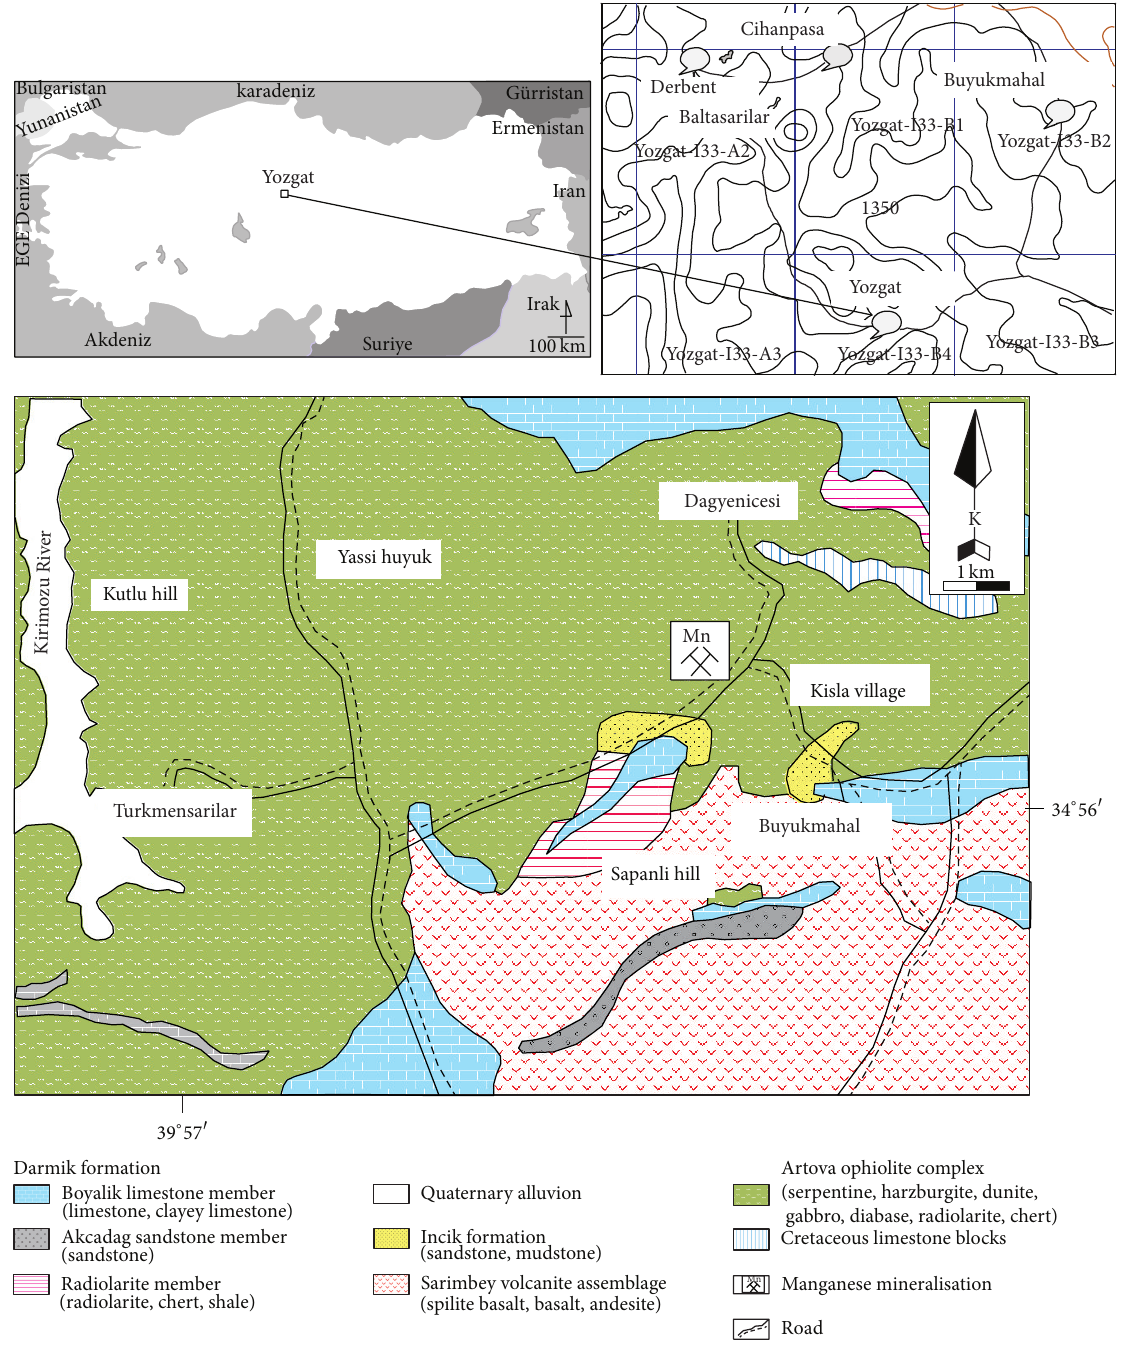
Figure 1: Location and geology map of study area (modified from [12]).